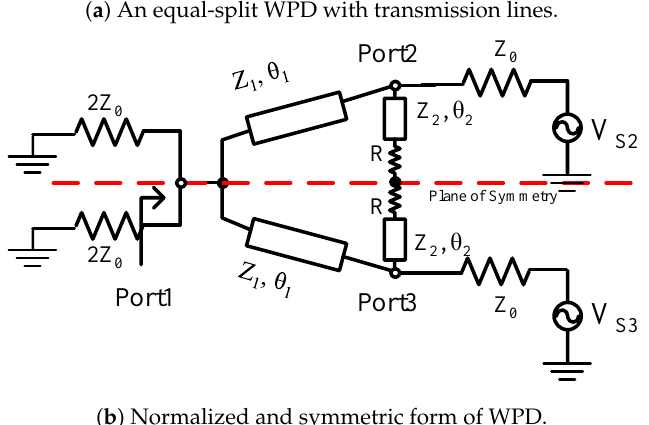
Figure 2. Proposed WPD circuit with λ /4 transmission lines of characteristic impedances of Z 1 and Z 2 ,